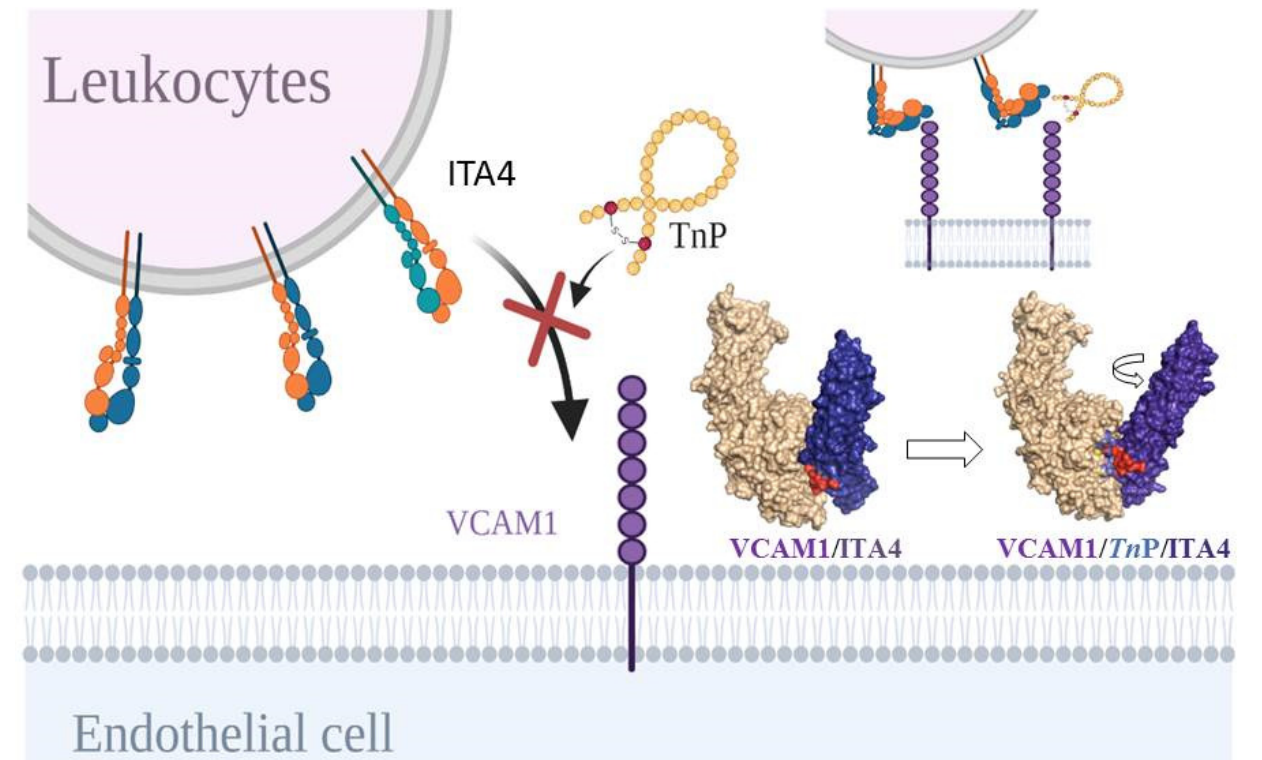
Figure 6. The cartoon illustrates the possible mechanism of action of Tn P. The in silico model built to predict the possible molecular targets of Tn P showed a harmonic resonance between the anti-inflammatory effects and the computational modeling. The binding mode of Tn P showed that it overlapped the ITA4/VCAM-1 binding cleft, leading to a decrease in interaction, with a subsequent reduction in the binding strength and protein fixation in the bending form that decreases its activation. The PDB file ITA4 and VCAM-1 were acquired from SWISS-MODEL using the reference ITA4_HUMAN and